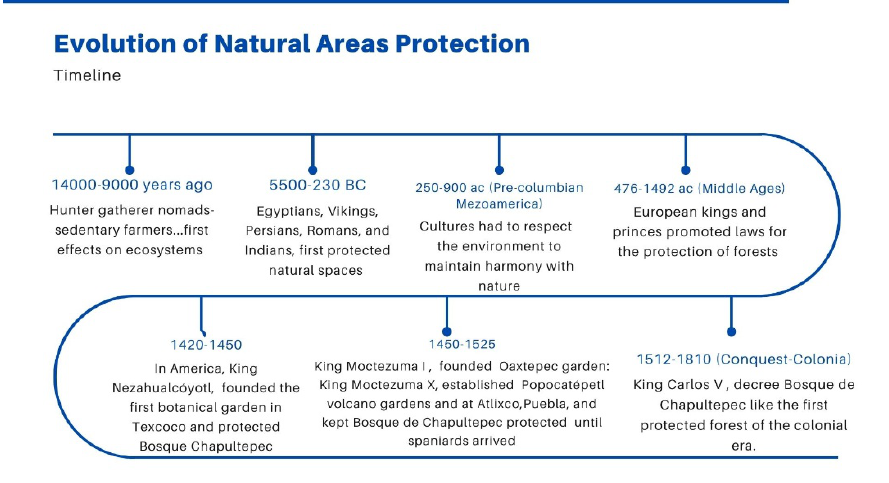
Figure 1. Timeline of the evolution of Natural Protected Areas until the 20th Century.